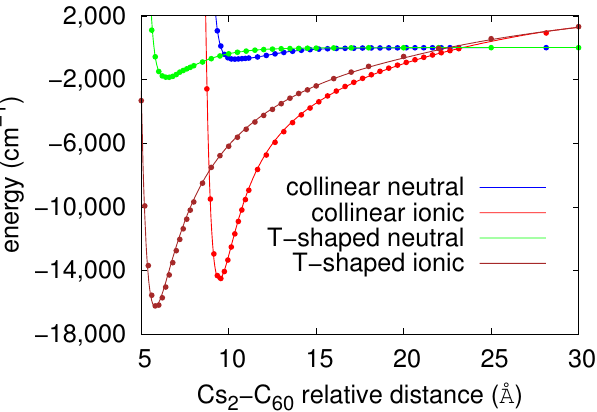
Figure 1. Diabatic potential energy curves characterizing the neutral Cs 2 -C 60 and ionic Cs + interactions as function of their relative distance R at collinear and T-shaped orientations. Points: ab initio calculations; solid lines: analytic fits, see text.